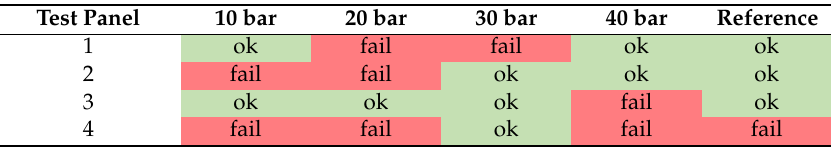
Table 1. Results of the dynamic electrical test after FAM process of five test panels. The reference test panel underwent the FAM process without EMC encapsulation in order to be exposed to the same temperature record like the other four normally processed test panels.